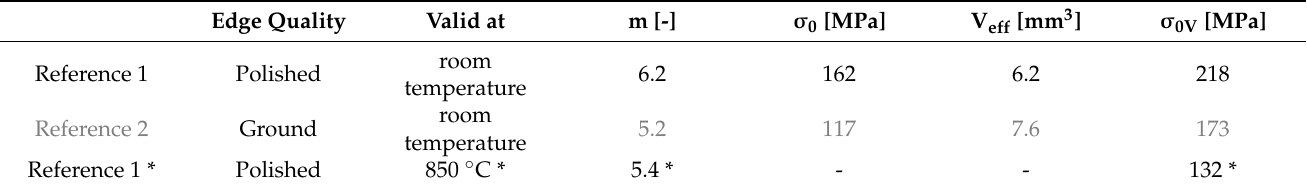
Table 4. Weibull parameters, effective volume, and resulting normalized strength of brittle ring tests of the reference series. * Scaled from room temperature to 850 ◦ C.